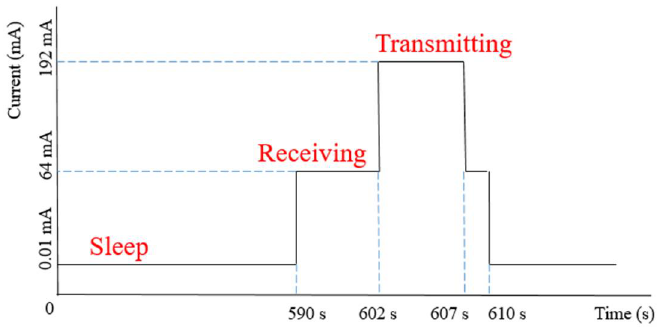
Figure 10. Timing diagram of sensor node operation.